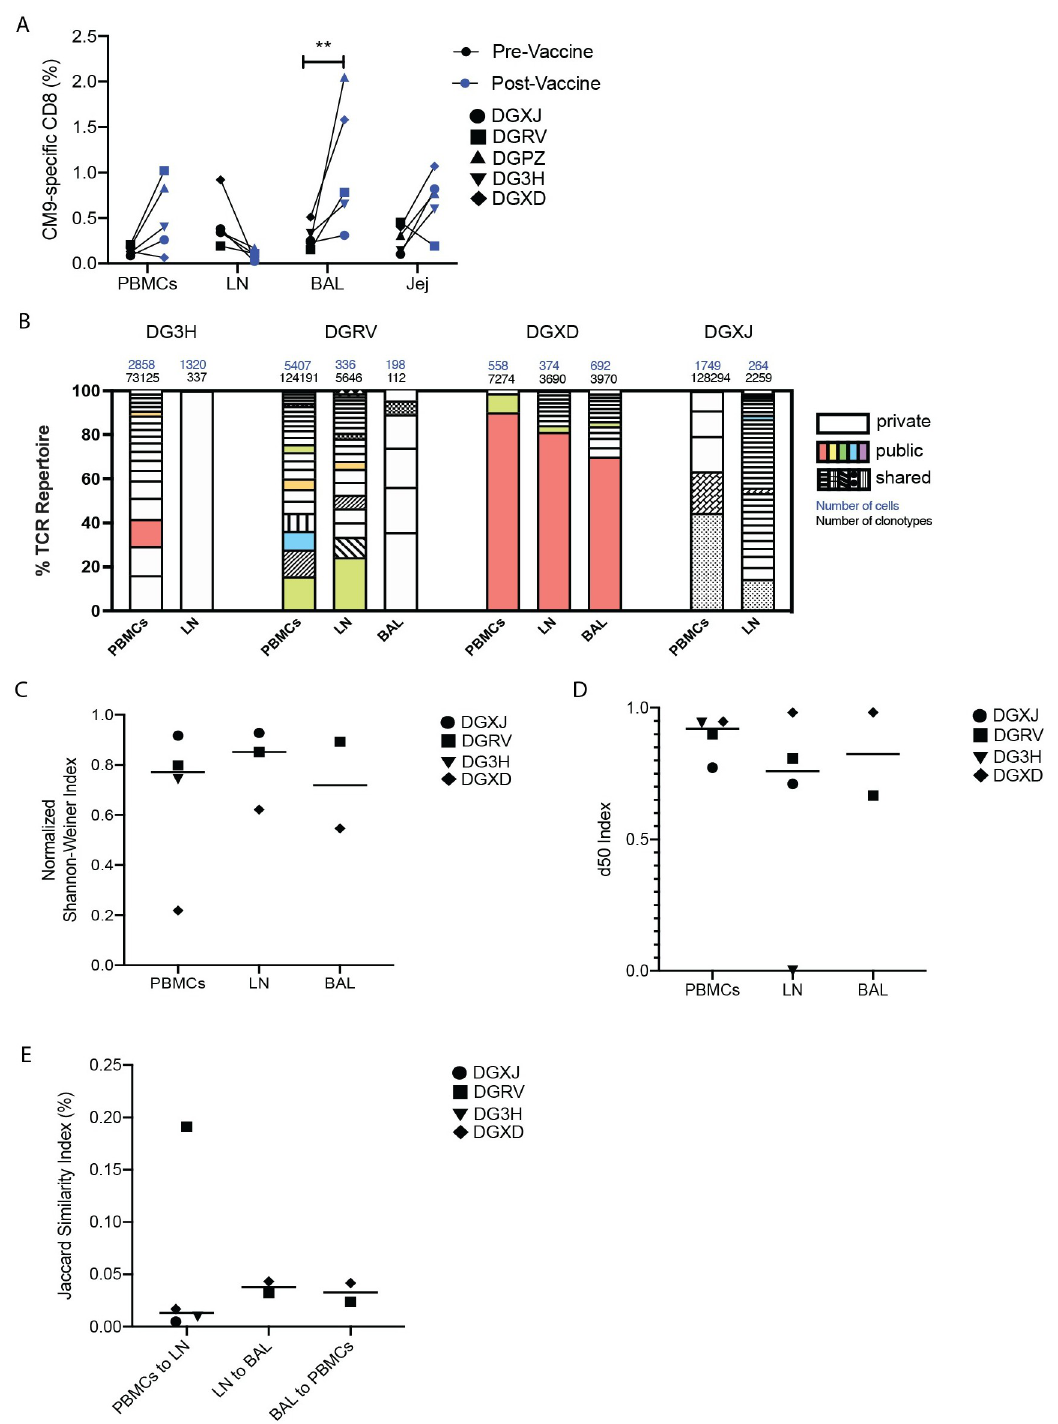
Fig 3. SIV-gag DNA vaccine induced a diverse TCR repertoire and tissue-specific clonotypes. PBMCs, BAL, LN, and jejunum (jej) biopsies were sampled from rhesus macaques who had been administered with SIV-gag DNA vaccine. (A) CM9-specific CD8 + T cells in all tissues pre- and post- vaccine administration as a percentage of total CD8 + cells. (B) Clonotypes consisting of more than 1% of the TCR repertoire are represented as percentage of the TCR repertoire. “Public” clonotypes are the same clonotype (same V and J segments and same CDR3 amino acid sequence) found in multiple animals in this study, and matching clonotypes previously identified in the VDJdb database. “Shared” clonotypes were those found only in one animal but observed in multiple tissues. “Private” clonotypes were identified in a single anatomical site in a single animal. Total cell and TCR sequences numbers